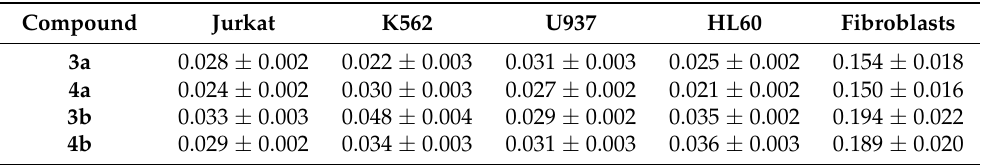
Table 2. Cytotoxic activities IC 50 in vitro of bicyclo[4.2.1]nona-2,4,7-trienes 3 , 4a , b measured on tumor cell cultures (Jurkat, K562, U937, HL60) and normal fibroblasts ( µ M). Compound Jurkat K562 U937 HL60 Fibroblasts 3a 0.028 ±